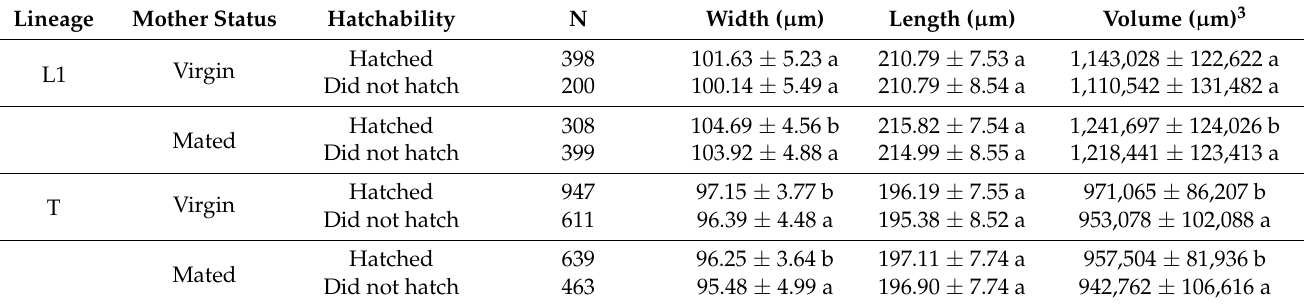
Table 1. Size of hatched and unhatched eggs in the virgin and mated mothers of the L1 and T